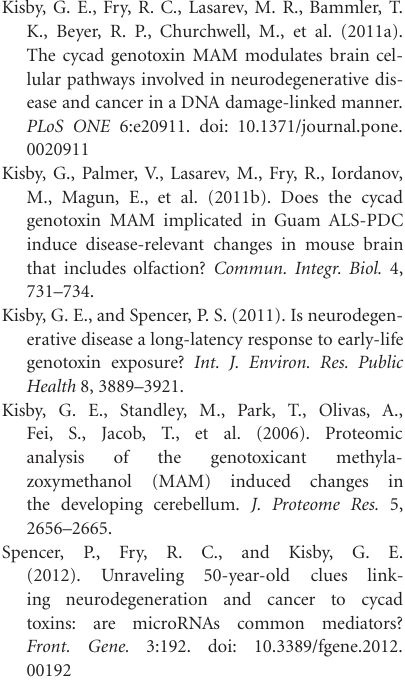
FIGURE 1 | Proposed common pathway underlying cancer and neurodegenerative disease that is mediated by DNA damage and epigenetic changes (modified from Spencer et al., 2012).